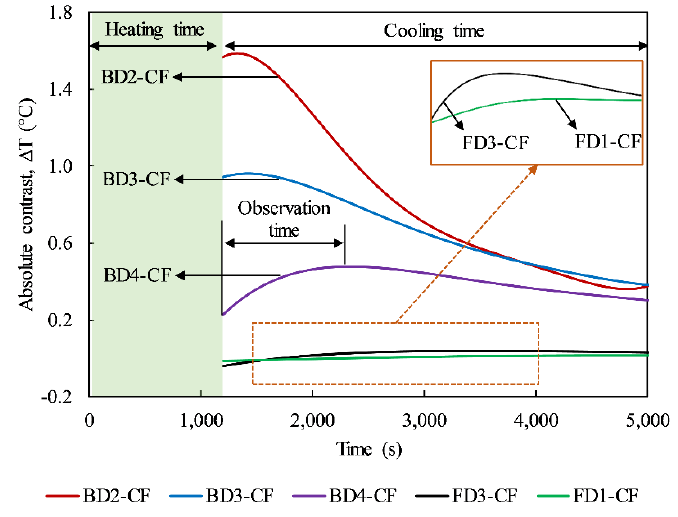
Figure 6. Absolute contrast curves for delaminations with 20 min heating.